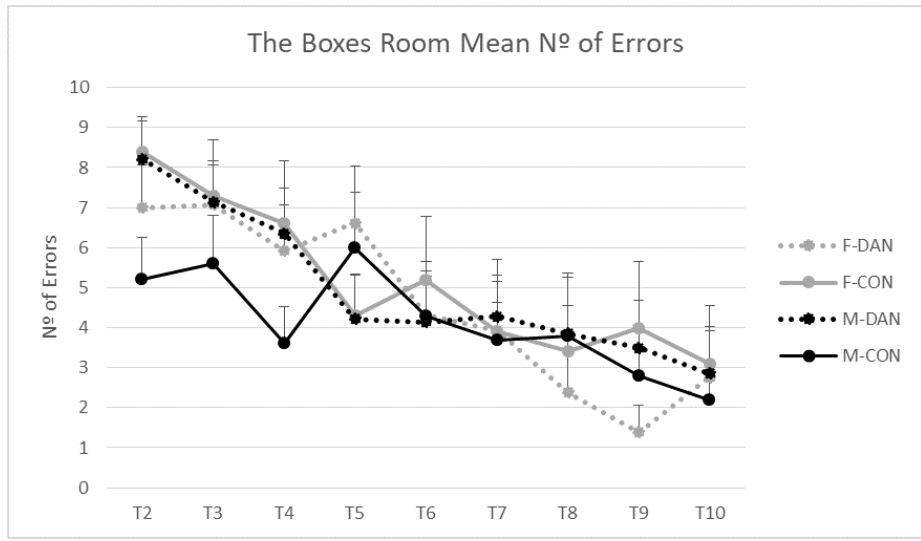
Figure 7. Number of errors in the spatial memory task. All groups improved across trials. Groups did not differ in the number of mistakes in the task. Male dancing (M-DAN); female dancing (F-DAN); male control (M-CON); female control (F-CON). Mean + SEM.